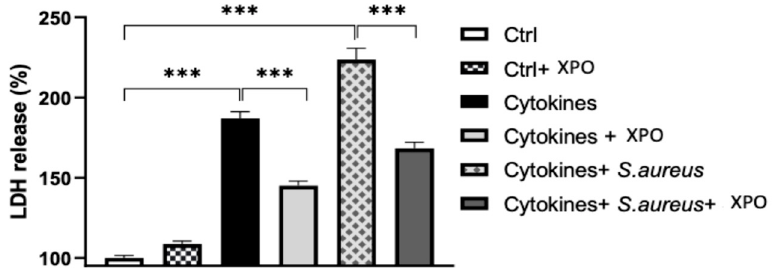
Figure 3. LDH release. LDH release was significantly increased in the cell culture supernatant after incubation with cytokines or with cytokines + S. aureus compared with control group. XPO treatment reduced the percentage of LDH released by HaCaT keratinocytes. Values are indicated as the mean ± SEM. *** p < 0.001.